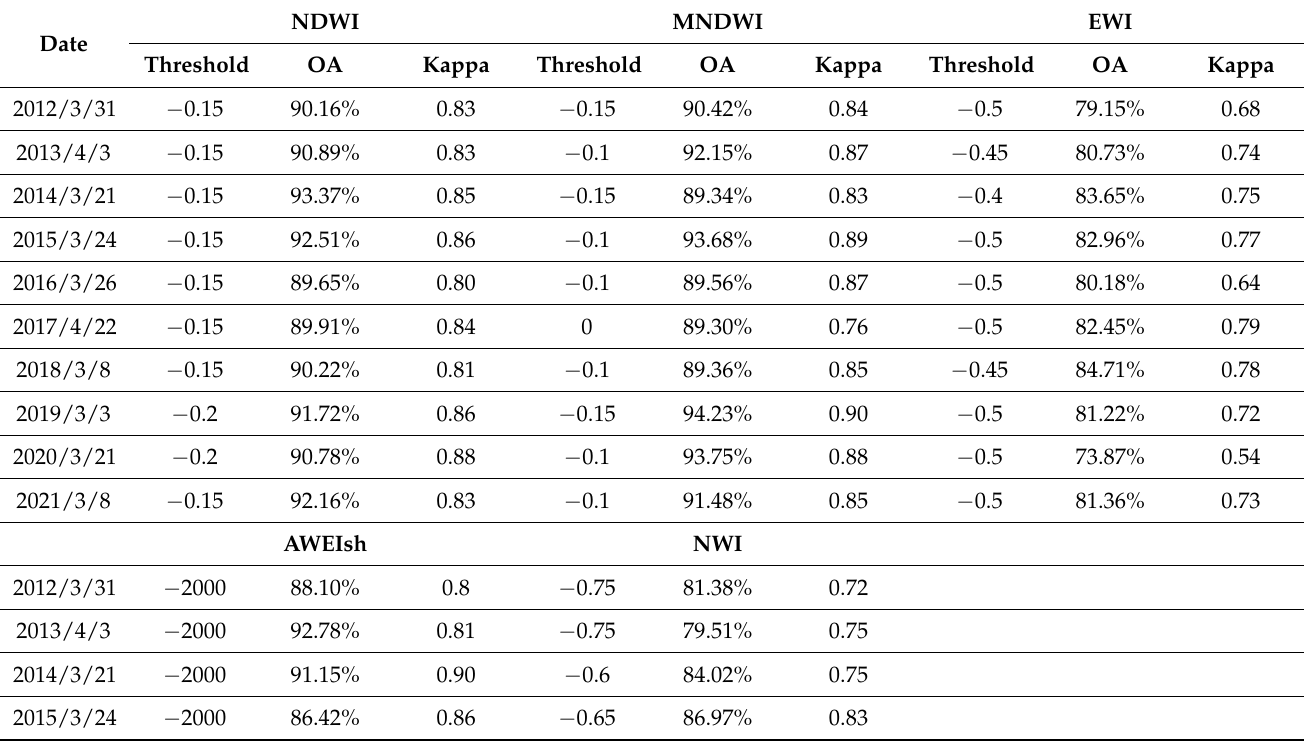
Table 3. Extraction accuracy of the water